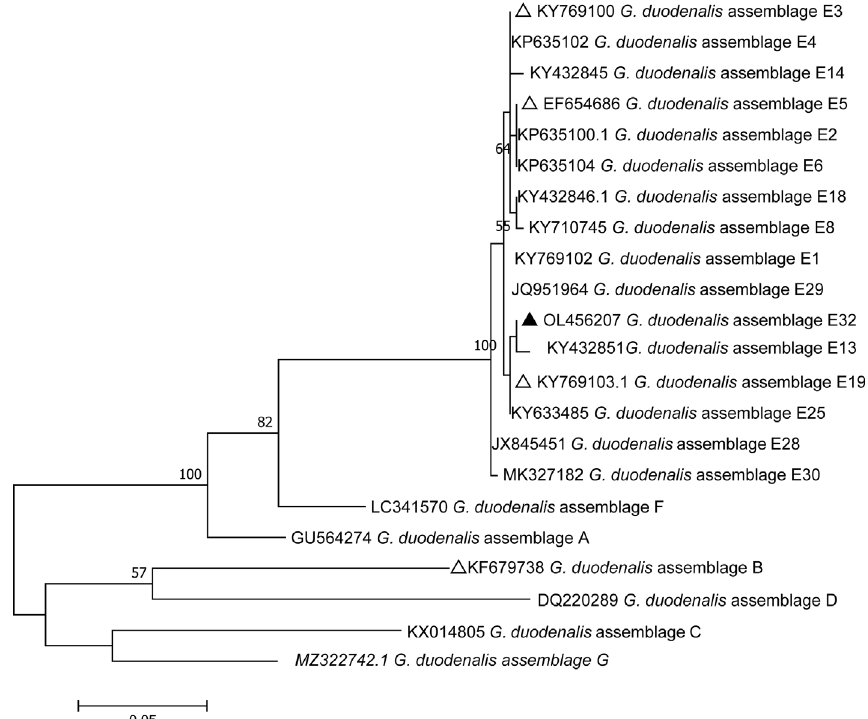
Figure 4. Phylogenetic relationships of triose phosphate isomerase ( tpi ) nucleotide sequences of G. duodenalis assemblages (A – G) and assemblage E subtypes, using the maximum composite likelihood model. Percent bootstrap values greater than 50% from 1000 replicates are shown next to the branches. The black triangles and hollow triangles represent published and novel isolates in this